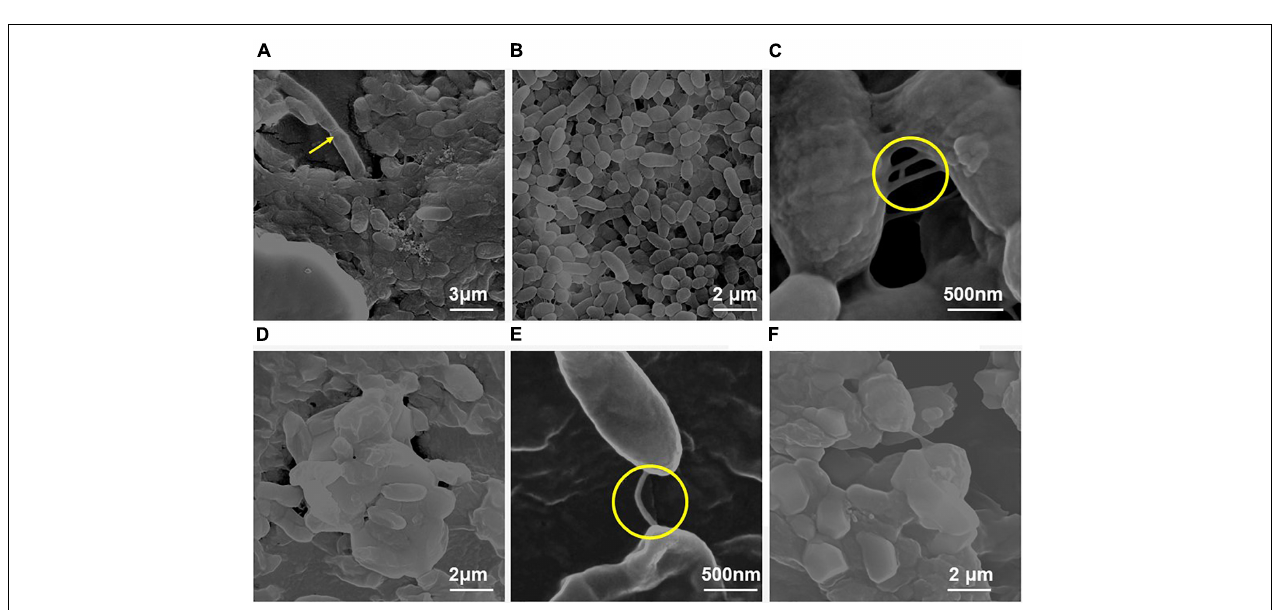
FIGURE 2 | Scanning electron micrographs of the biofilm formed by E. Cloacae SBP-8 on an enteral feeding tube at varying time durations from 24 to 96 h. (A) Adherence of bacteria onto the surface with a slight production of EPS at 24 h with the presence of few dividing cells (magnification: 24,000 × ). (B) Biofilm formation at 48 h of growth (magnification: 40,000 × ), with cells engrained in EPS matrix and having smooth morphology. The encircled area shows the presence of nanotubes tubes at 48 h. (C) The magnified image of biofilm after 48 h clearly shows thick multilayers of EPS and a nanotube-like structure (encircled area) between the cells (magnification: 1,60,000 × ). (D) At 72 h, clusters of cells were aggregated in a thick layer of EPS (magnification: 40,000 × ). (E) A magnified image of the biofilm after 72 h clearly shows a nanotube joining the two cells in a biofilm (magnification: 1,60,000 × ). (F) Deeply embedded bacterial cells in their EPS matrix at 96 h (magnification: 40,000 × ).